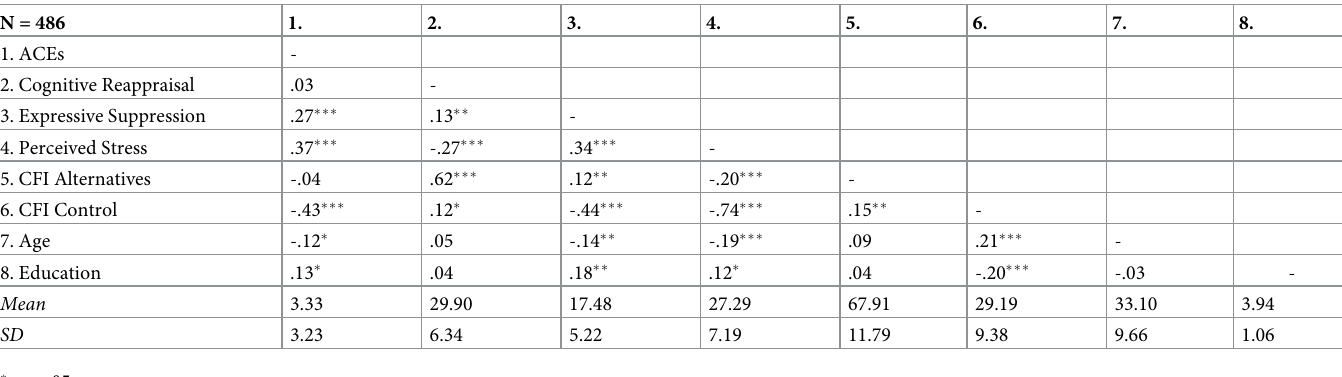
Table 1. Bivariate correlations and descriptive